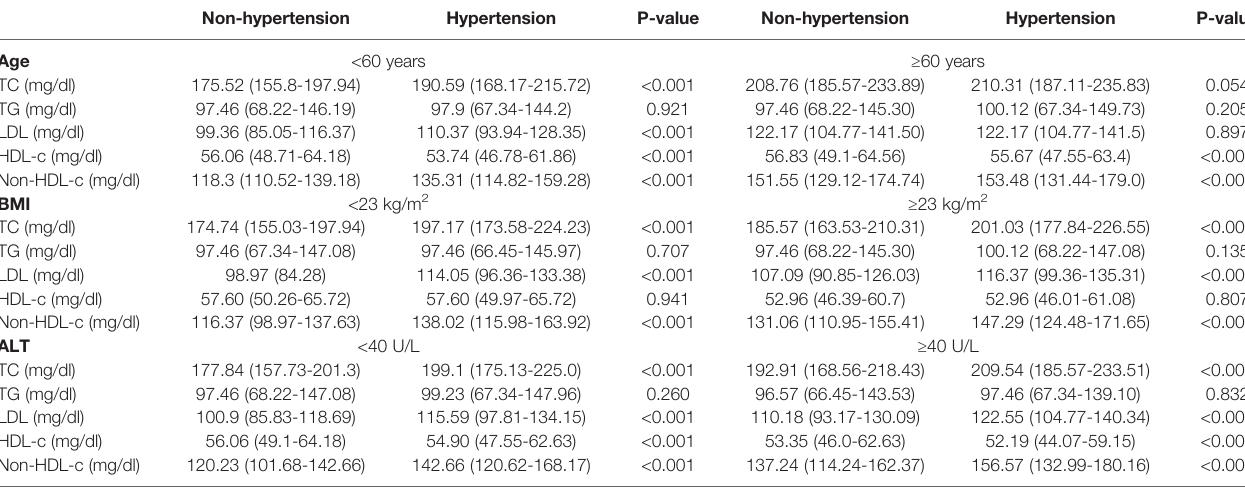
TABLE 2 | Subgroup analysis of lipid pro fi les differences between non-hypertension and hypertension according to age, BMI, and